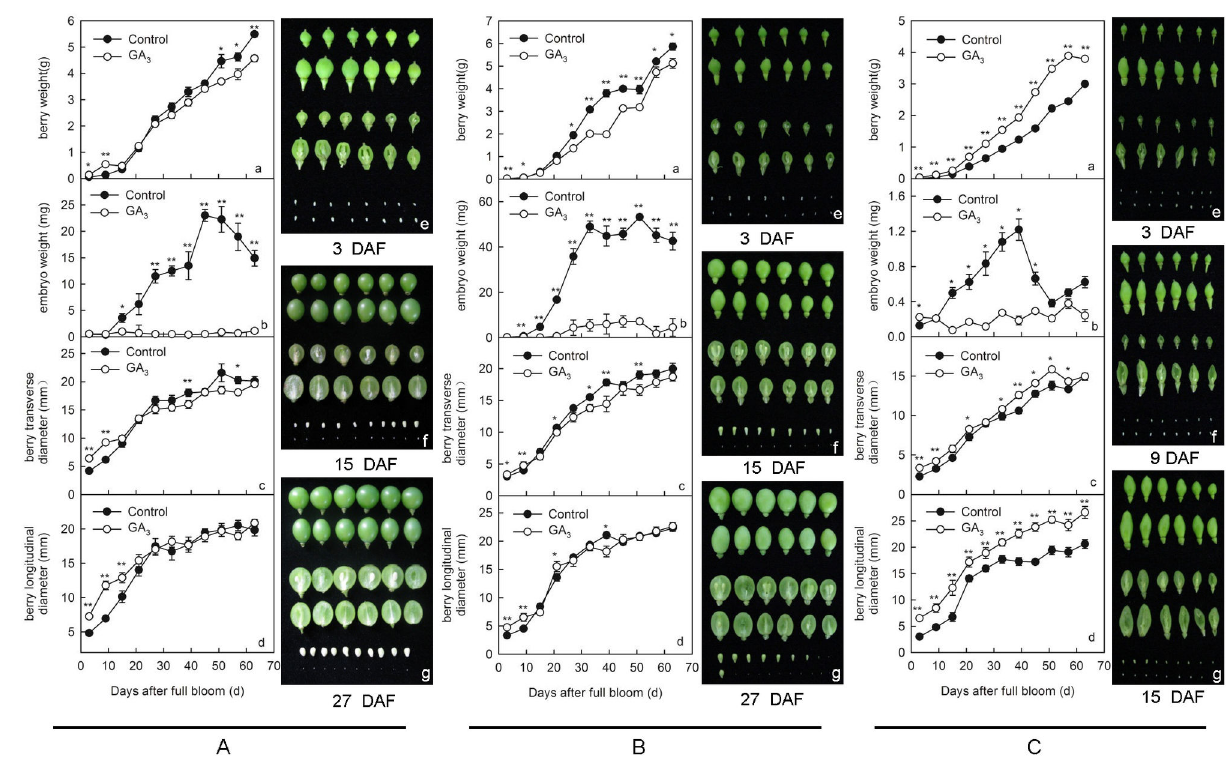
Figure 1. Effect of GA treatment on the shape and size of ‘Kyoho’, ‘Red Globe’ and ‘Thompson Seedless’ berries and 3 seeds. Berry weight (a), seed weight (b), berry transverse diameter (c) and berry longitudinal diameter (d) in ‘Kyoho’ (A) and ‘Red Globe’ (B) cultivars. Photos are representative of untreated control and treated berries and seeds at 3 DAF (21 days after treatment in ‘Kyoho’ and 19 days after treatment in ‘Red Globe’) (e), 15 DAF (33 days after treatment in ‘Kyoho’ and 31 days after treatment in ‘Red Globe’) (f) and 27 DAF (45 days after treatment in ‘Kyoho’ and 43 days after treatment in ‘Red Globe’) (g); (C) Berry weight (a), seed weight (b), berry transverse diameter (c) and berry longitudinal diameter (d) in the ‘Thompson Seedless’ cultivar. Photos are representative of untreated control and treated berries and seeds at 3 DAF (19 days after treatment) (e), 9 DAF (25 days after treatment) (f) and 15 DAF (31 days after treatment) (g). Vertical bars indicate standard errors. Asterisks indicate significant differences between GA treated and untreated control samples (*P < 0.05, **P < 0.01, Student’s t–test). In each column, the first 3 and second photos represent untreated control and GA -treated berries, respectively, the third and fourth photos represent 3 longitudinal sections of untreated control and GA -treated berries, respectively, and the fifth and sixth photo represent untreated 3 control and GA -treated seeds, respectively. 3